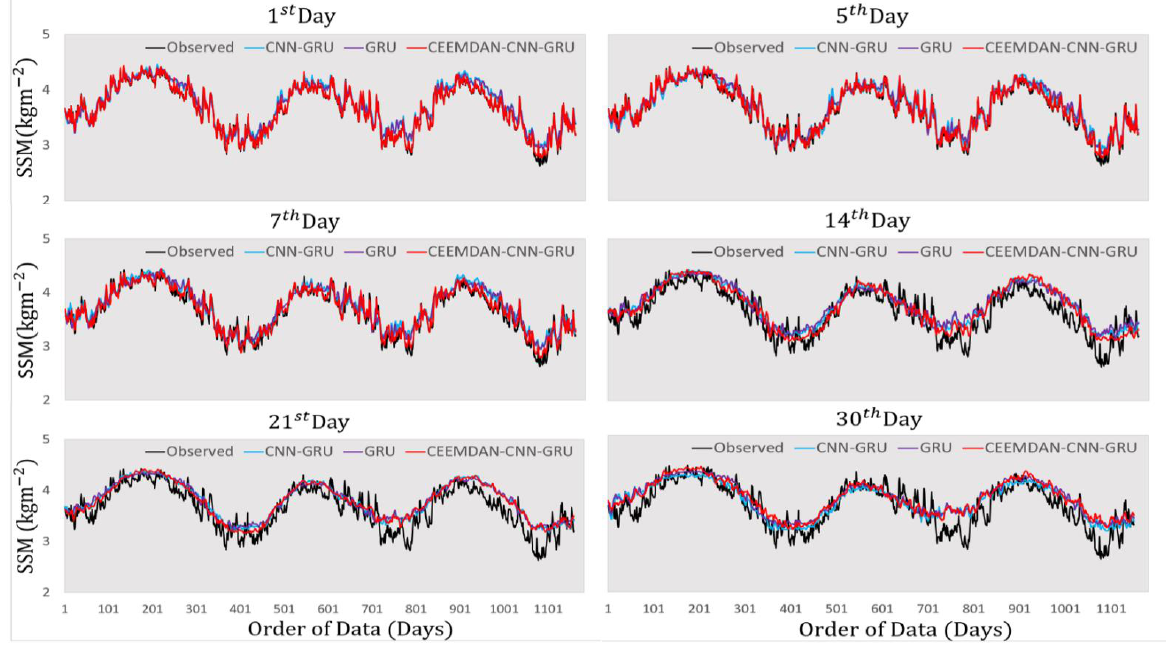
Figure 7. Time series of daily surface soil moisture (SSM, kg m −2 ) for observed SSM (Gray) and Figure 1. 5, 7, 14, 21, and 30) day lead times.